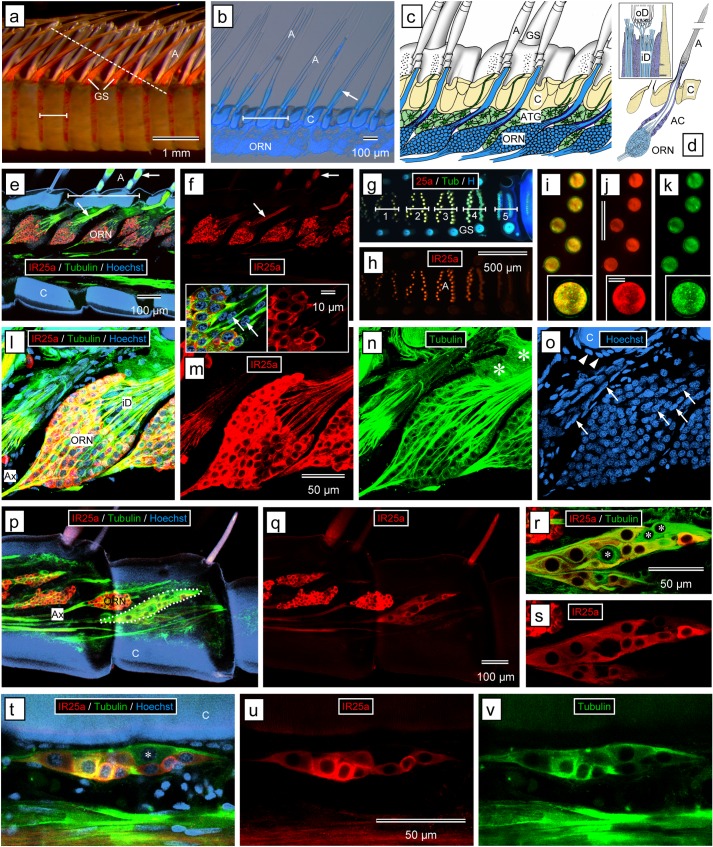
Immunolabeling with anti-HaIR25a in the lateral flagellum of the antennule.(a–s) Aesthetascs-bearing tuft region of the lateral flagellum. (a) Outer morphology—stereomicroscopical image. Each annulus (horizontal bar) bears two rows of transparent aesthetascs (A) accompanied by guard setae (GS). Dashed line shows direction of cross section through aesthetascs in (g–k). (b) Sagittal section labeled with Hoechst 33258 showing full length of aesthetasc setae (A). Each annulus (horizontal bar) bears two rows of aesthetascs. ORN clusters (ORN) are labeled by Hoechst whereas cuticle (C) is autofluorescent. Only the proximal 20% of the cuticle of the aesthetasc setae containing the inner dendritic segments of the ORNs is autofluorescent (arrow). (c) Sagittal view of the lateral flagellum (modified from Schmidt et al. (2006) [87]). Each aesthetasc (A) is innervated by a cluster of ORNs (blue) whose inner dendritic segments traverse the cuticle (C) in a wide canal. ORN clusters are associated with subcuticular aesthetasc tegumental glands (ATG) whose thin drainage ducts terminate in pores at the base of the aesthetascs. Guard setae (GS) are located at the lateral margins of the aesthetasc rows. (d) Reconstruction of aesthetasc ultrastructure based on transmission electron microscopy; inset: region of transition from inner to outer dendritic segments within the base of aesthetasc setae at higher magnification (modified from Grünert and Ache (1988) [94]). Each aesthetasc (A) is innervated by about 320 ORNs whose somata form a cluster (ORN) below the cuticle (C). Inner dendritic segments arising apically from the ORN somata are wrapped by auxiliary cells (AC). Inset: each inner dendritic segment (iD) gives rise to two highly-branched outer dendritic segments (oD). (e, f) Sagittal section through medial plane of the tuft region of a lateral flagellum labeled with anti-HaIR25a (red), anti-tubulin (green), and Hoechst 33258 (blue) at low magnification (confocal images). Scale bar in (e) also applies to (f). (e) Overlay of all three fluorescence channels. (f) anti-HaIR25a channel. Two rows of aesthetascs setae (A) arise from the intensely autofluorescent (blue) cuticle of an annulus (horizontal bar in e). Each aesthetasc seta is associated with a clearly delineated cluster of ORN somata (ORN). The somata and inner dendritic segments (arrows) are intensely labeled by anti-HaIR25a and anti-tubulin. (g–k) Cross sections through aesthetasc setae (direction of section indicated by dashed line in (a)). (g, h) Low magnification epifluorescence images; scale bar in (h) also applies to (g). (g) Overlay of all three fluorescence channels. (h) anti-HaIR25a channel. Aesthetasc setae (A) located on different annuli (horizontal bars with numbers) are cut at different levels systematically progressing from the tips (1) to the base emerging from the annulus cuticle (5). Note that the lumen of the aesthetasc setae containing outer dendritic segments (1, 2, 3, 4—left aesthetasc row) is more intensely labeled by anti-HaIR25a than the lumen of aesthetasc setae containing only inner dendritic segments (4 –right aesthetasc row, 5). (i–k) High magnification epifluorescence images of sections through aesthetasc setae on annulus 3; insets: very high magnification (confocal images); scale bars in (j) (top: 50 μm; bottom: 10 μm) also apply to (i) and (k). (i) Overlay of anti-HaIR25a and anti-tubulin fluorescence channels. (j) anti- HaIR25a channel. (k) anti-tubulin channel. Note that entire lumen of aesthetasc setae is filled by outer dendritic segments of ORNs intensely labeled by anti-HaIR25a and anti-tubulin. (l–o) Sagittal section through ORN clusters labeled with anti-HaIR25a (red), anti-tubulin (green), and Hoechst 33258 (blue) at high magnification (confocal images–maximum intensity projection of entire stack of optical sections spanning about 60 μm). Scale bar in (m) also applies to (l), (n), and (o). (l) Overlay of all 3 fluorescence channels. (m) anti-HaIR25a channel. (n) anti-tubulin channel. (o) Hoechst channel. Insets in (m): Apical region of ORN cluster at high magnification; left, overlay of all 3 fluorescence channels; right, anti-HaIR25a channel (confocal images of a single optical section). The somata (ORN), axons (Ax), and inner dendritic segments (iD) of all ORNs are intensely labeled by anti-HaIR25a and anti-tubulin. Somata of auxiliary cells (nuclei indicated by arrows) are not labeled by either of the antibodies and epithelial cells (nuclei indicated by arrowheads) and aesthetasc tegumental glands (asterisks) are labeled by anti-tubulin but not anti-HaIR25a. Autofluorescent (blue) cuticle (C). (p–s) Sagittal section through lateral plane of tuft region of lateral flagellum labeled with anti-HaIR25a (red), anti-tubulin (green), and Hoechst 33258 (blue). (p, q) Section at low magnification (confocal images); scale bar in (q) also applies to (p). (p) Overlay of all three fluorescence channels. (q) anti-HaIR25a channel. In addition to clusters of ORN somata, clusters of sensory neurons innervating bimodal sensilla accompanying the aesthetascs (one cluster outlined by white dots) are also labeled by anti-HaIR25a and anti-tubulin. The intensity of labeling with anti-HaIR25a is higher in ORN somata and axons (Ax) than in somata and axons of the other sensory neurons. (r, s) Section at high magnification (confocal images; scale bar in (r) also applies to (s). (r) anti-HaIR25a and anti-tubulin channel. (s) anti-HaIR25a channel. All sensory neurons of the clusters are labeled by anti-tubulin, but three of them (asterisks) mostly located in the distal aspect of the cluster are not double-labeled by anti-HaIR25a. (t–v) Sagittal section through cluster of sensory neurons innervating a bimodal sensillum in the proximal part of the lateral flagellum labeled with anti-HaIR25a (red), anti-tubulin (green) and Hoechst 33258 (blue). (t) Overlay of all three fluorescence channels. (u) anti-HaIR25a channel. (v) anti-tubulin channel. All sensory neurons of the clusters are labeled by anti-tubulin but one of them (asterisk) located in the distal aspect of the cluster is not double-labeled by anti-HaIR25a. The intensity of labeling with anti-HaIR25a and anti-tubulin differs substantially but independent of each other between labeled somata.